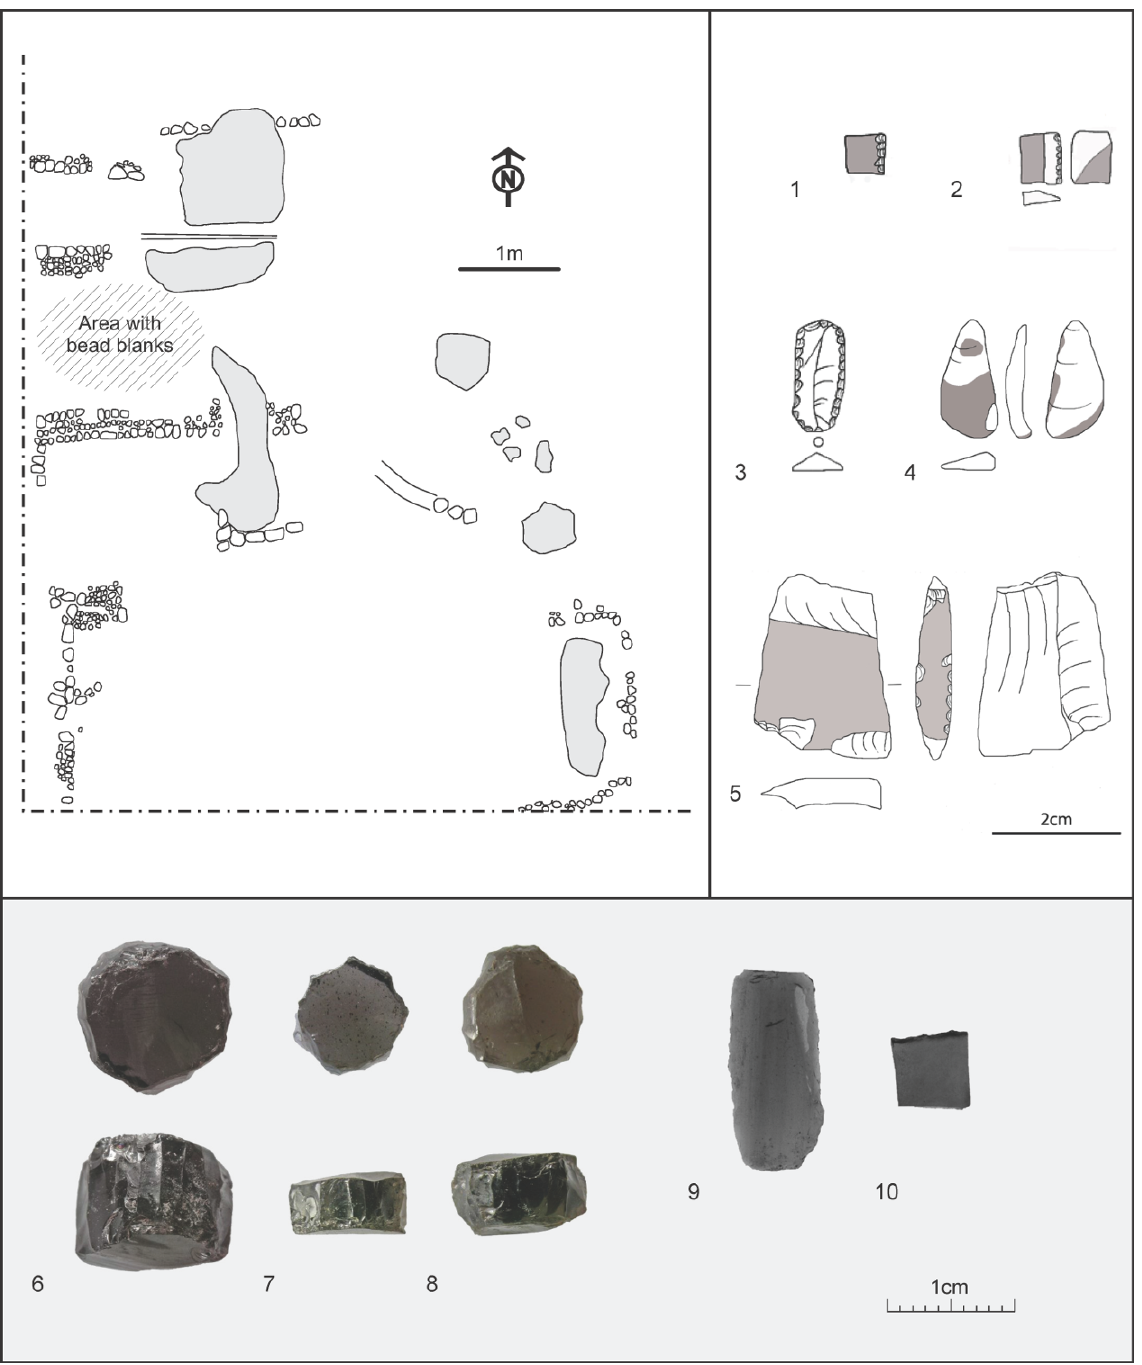
Figure 4. Upper left: Plan of activity areas around the Burnt Structure in Operation I at Domuztepe showing location of possible bead blanks. Right and lower: Square and rectangular blanks (nos. 1-3: L3919/10, L3959 and L4044). Incomplete pendant (no.4: dt4948). Incomplete tranchet (no. 5). Examples of discoidal bead blanks (nos. 6-8: dt4774, dt4595 and dt4835) and rectangular and square pieces (nos. 9 and 10: L3919-9 and L3919-10); L3919-10 is ground on its dorsal surface (Source, Stuart Campbell and Elizabeth